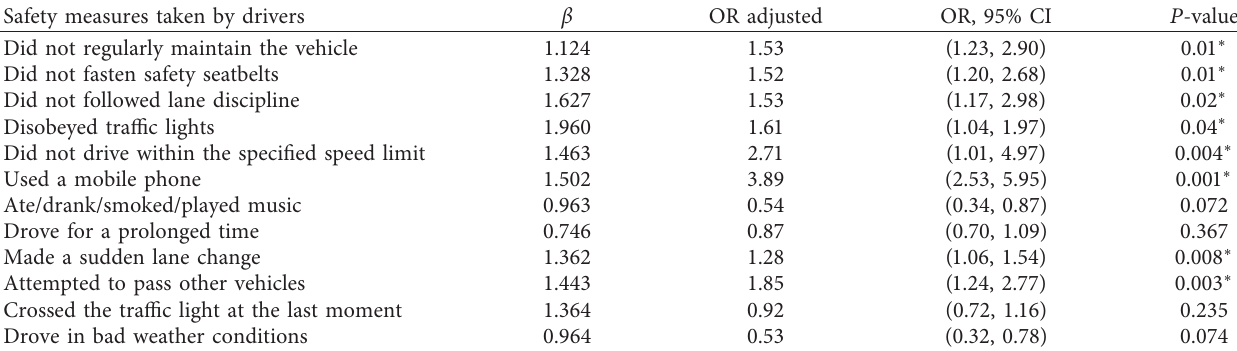
Table 4: Binary logistic regression model predicting the severity of injuries using safety measures taken by road crash victims ( n � 342). Safety measures taken by drivers